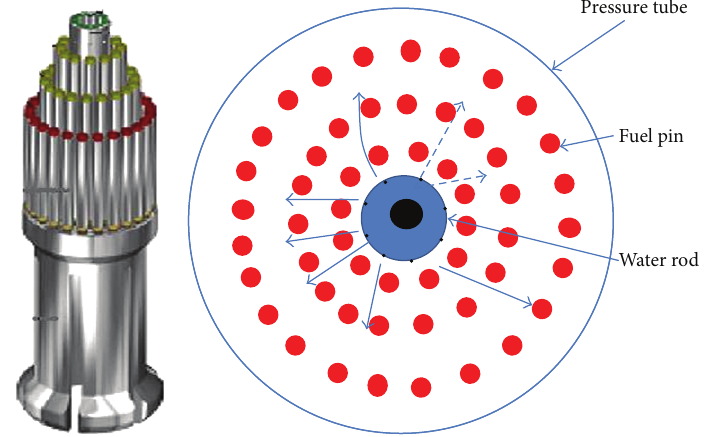
Figure 1: View of AHWR fuel